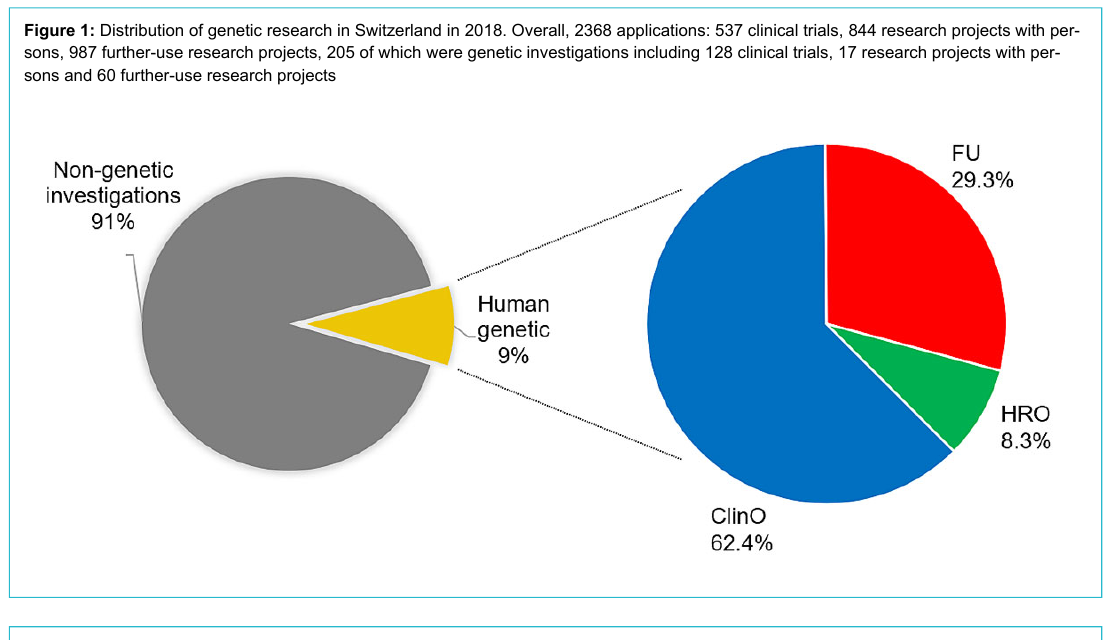
Figure 2: Distribution of sponsors/project leaders of clinical trials/research projectsBlue = clinical trials; green = research projects with per- sons; red = further-use research projects using health-related personal data or biological material; IND = Industry; IIT = Investigator-initiated trial; INS = Institutional sponsors = academia,